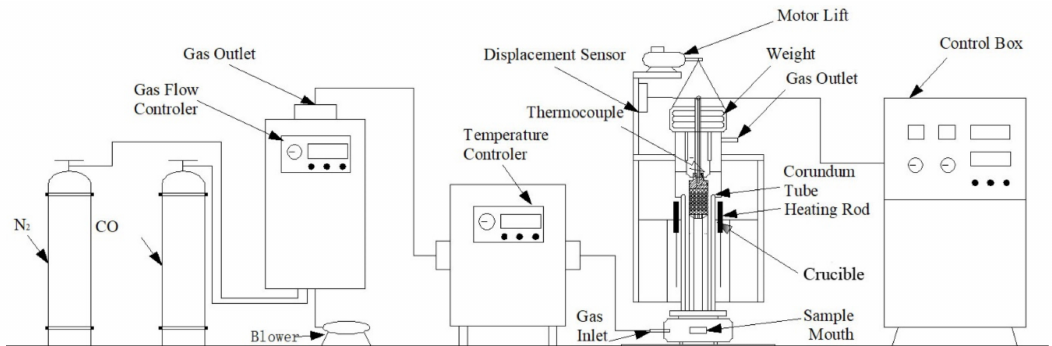
Figure 1. Schematic drawing of large capacity melting-drop furnace.